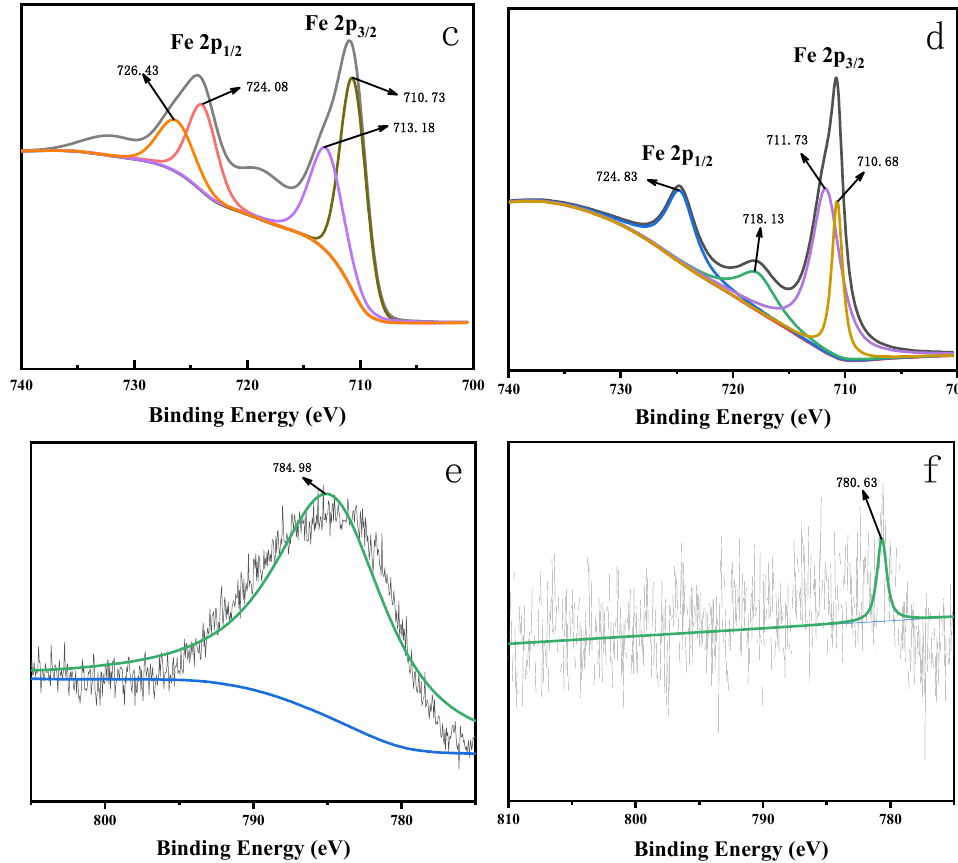
Figure 6. Full XPS of Co-nZVI /GAC reaction spectra ( a , b ) before and after Co-nZVI/GAC reaction; The narrow sweep spectra of Fe 2p before and after the reaction ( c , d ). The narrow scan patterns of Co before and after the reaction ( e , f ).